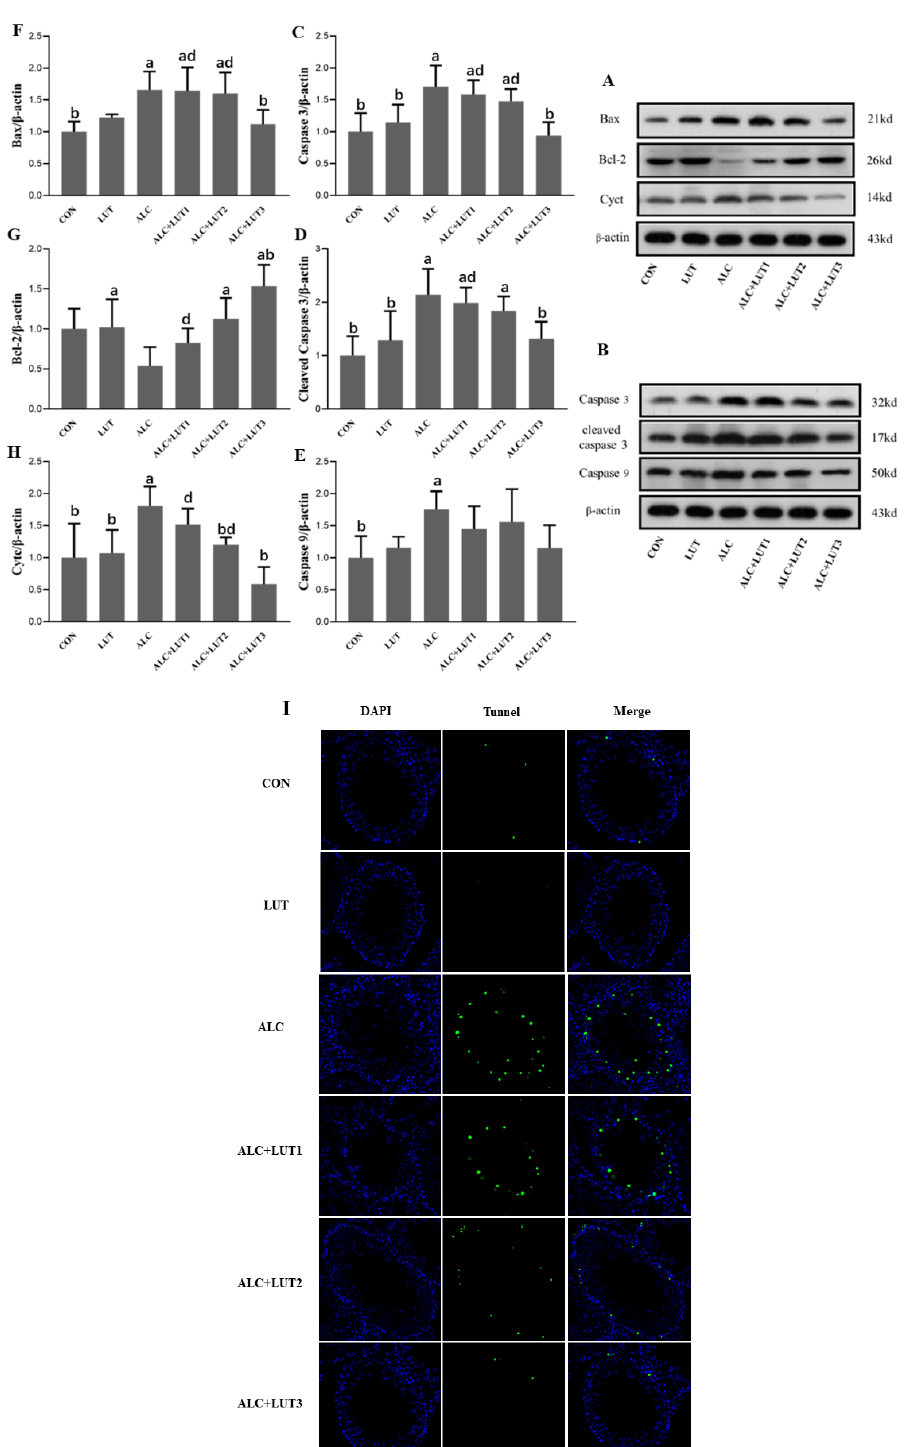
Figure 7. Apoptosis of testicular germ cells and expression of related proteins. ( A , B ) Western blot tests for apoptotic protein expression levels in testis. The protein levels of caspase-3 ( C ), cleaved